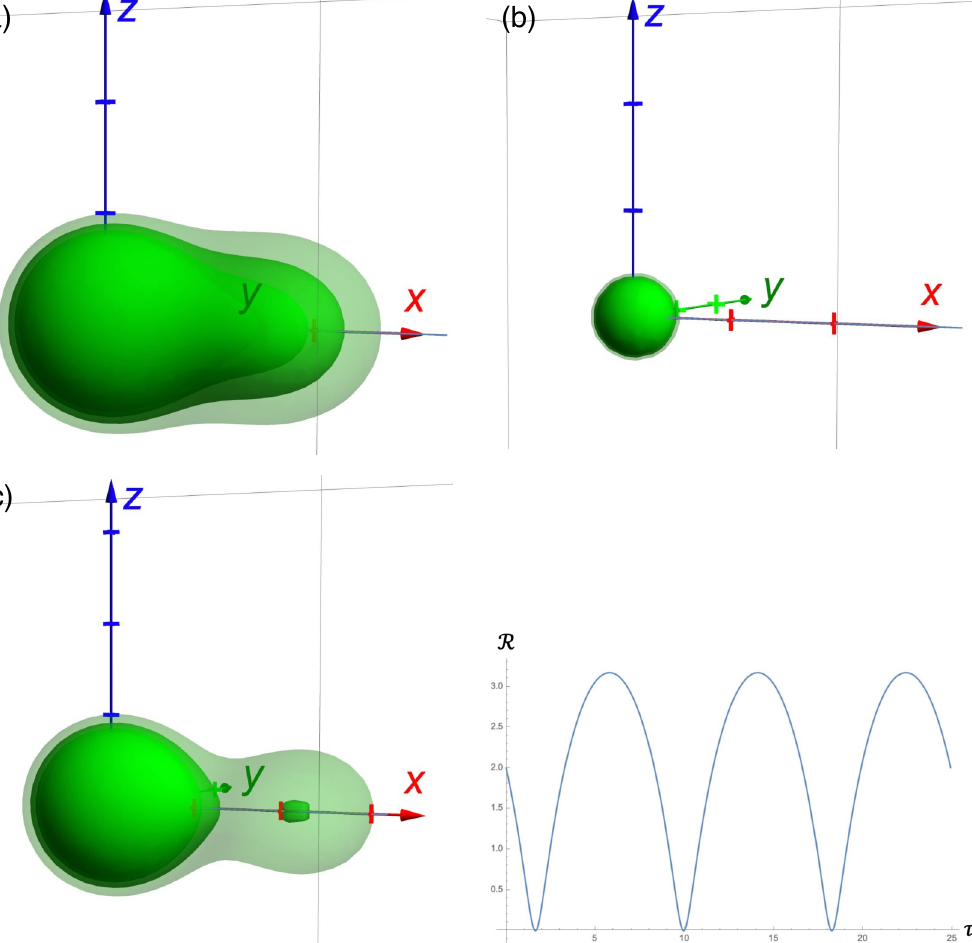
Figure 7 . Three frames from an oscillating solution and a plot of the defect-monopole distance as a function of time. The configuration has k = 2 , q = 0 , and C = 2 . The initial position and t momentum are ~ R = (2 , 0 , 0) and ~ p = ( − 1 , 0 , 0) . This gives E = 6 . 08 and a period of T = 8 . 30 , 0 0 which is consistent with (4.40). Frame (a) corresponds to τ = 0 , frame (b) to τ = 1 . 75 , and frame (c) to τ = 3 . 98